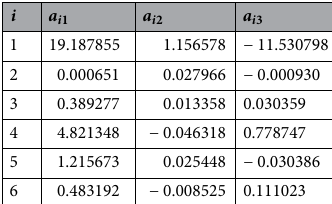
Table 4. The coefficients in f ( P , D ) estimation formula for fusiform leaf, using sample square.